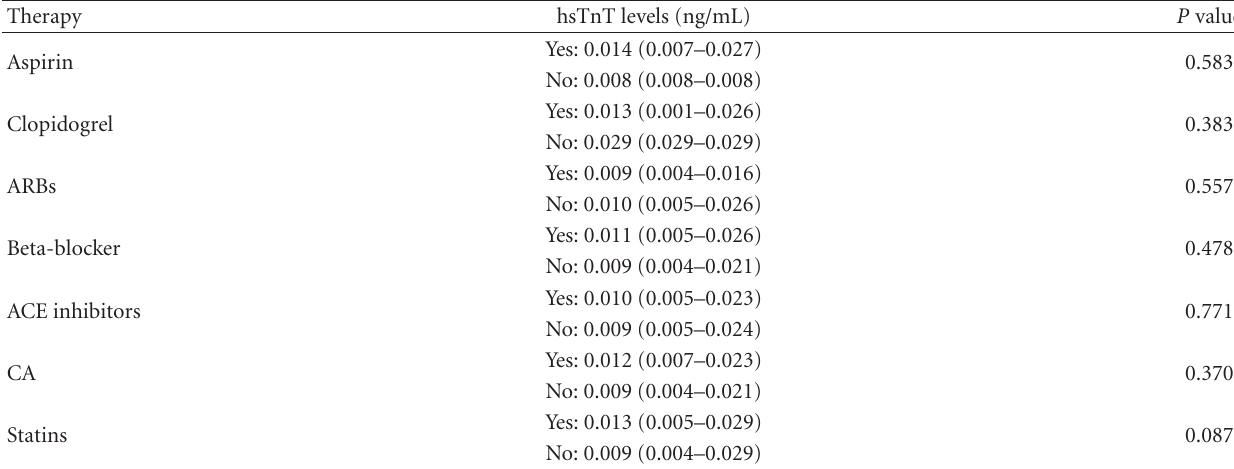
Table 2: hsTnT levels in relation to di ff erent modalities of drug